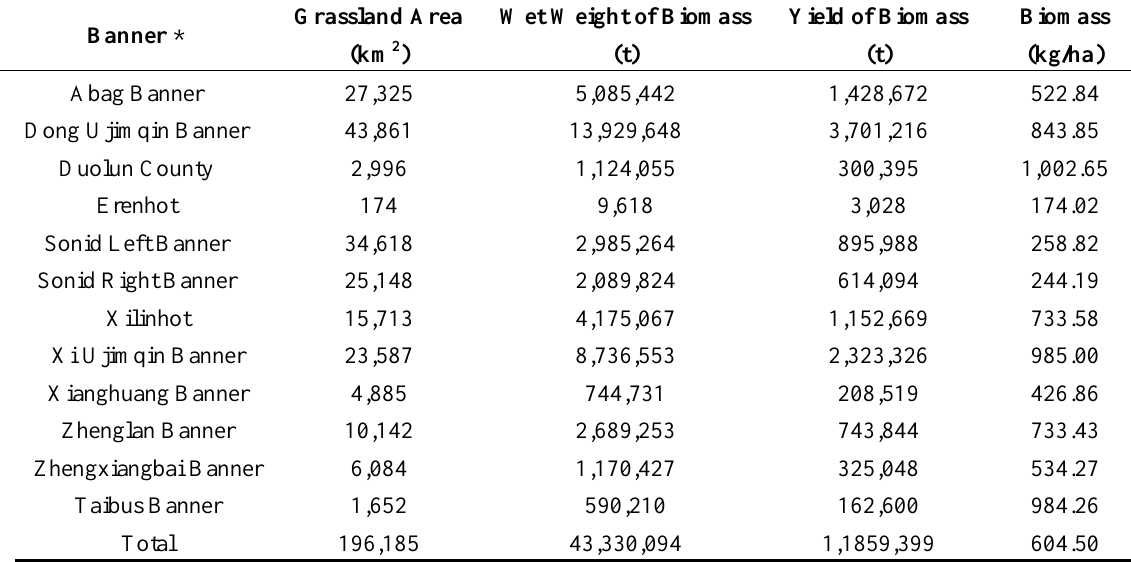
Table 4. The annual biomass of different